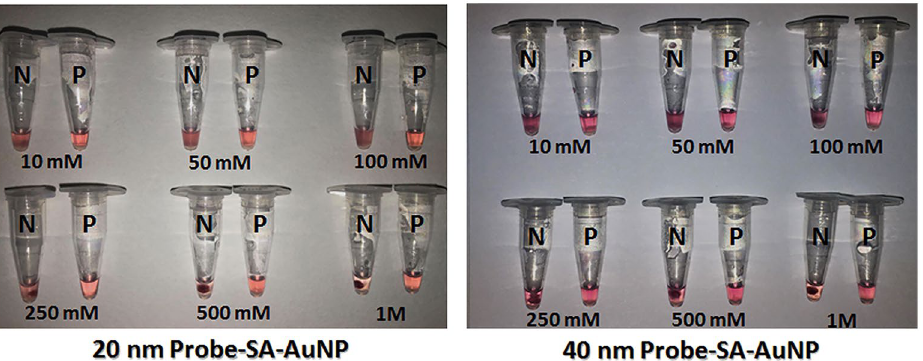
Figure 3. Effect of MgSO 4 concentration (10 to 1000 mM at a fixed volume) on inducing aggregation of 20 and 40 nm probe-SA-AuNPs. Abbreviations of variable names: no template control (N), positive template control